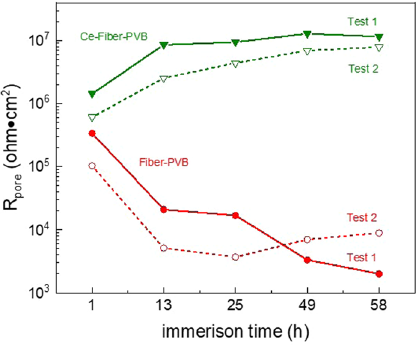
Fig. 8 Evolution of R pore of coated samples. Fiber-PVB and Ce- Fiber-PVB were immersed in 100 mM NaCl.